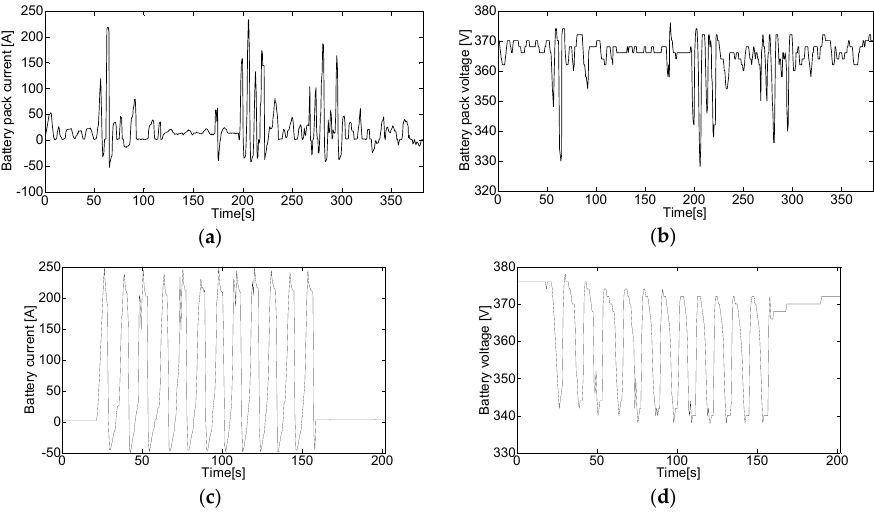
Figure 6. CAN bus measurements: ( a ) Battery pack current for the circular driving test; ( b ) Battery pack voltage for the circular driving test; ( c ) Battery pack current for the rapid acceleration and deceleration driving test; ( d ) Battery pack voltage for the rapid acceleration and deceleration driving test.